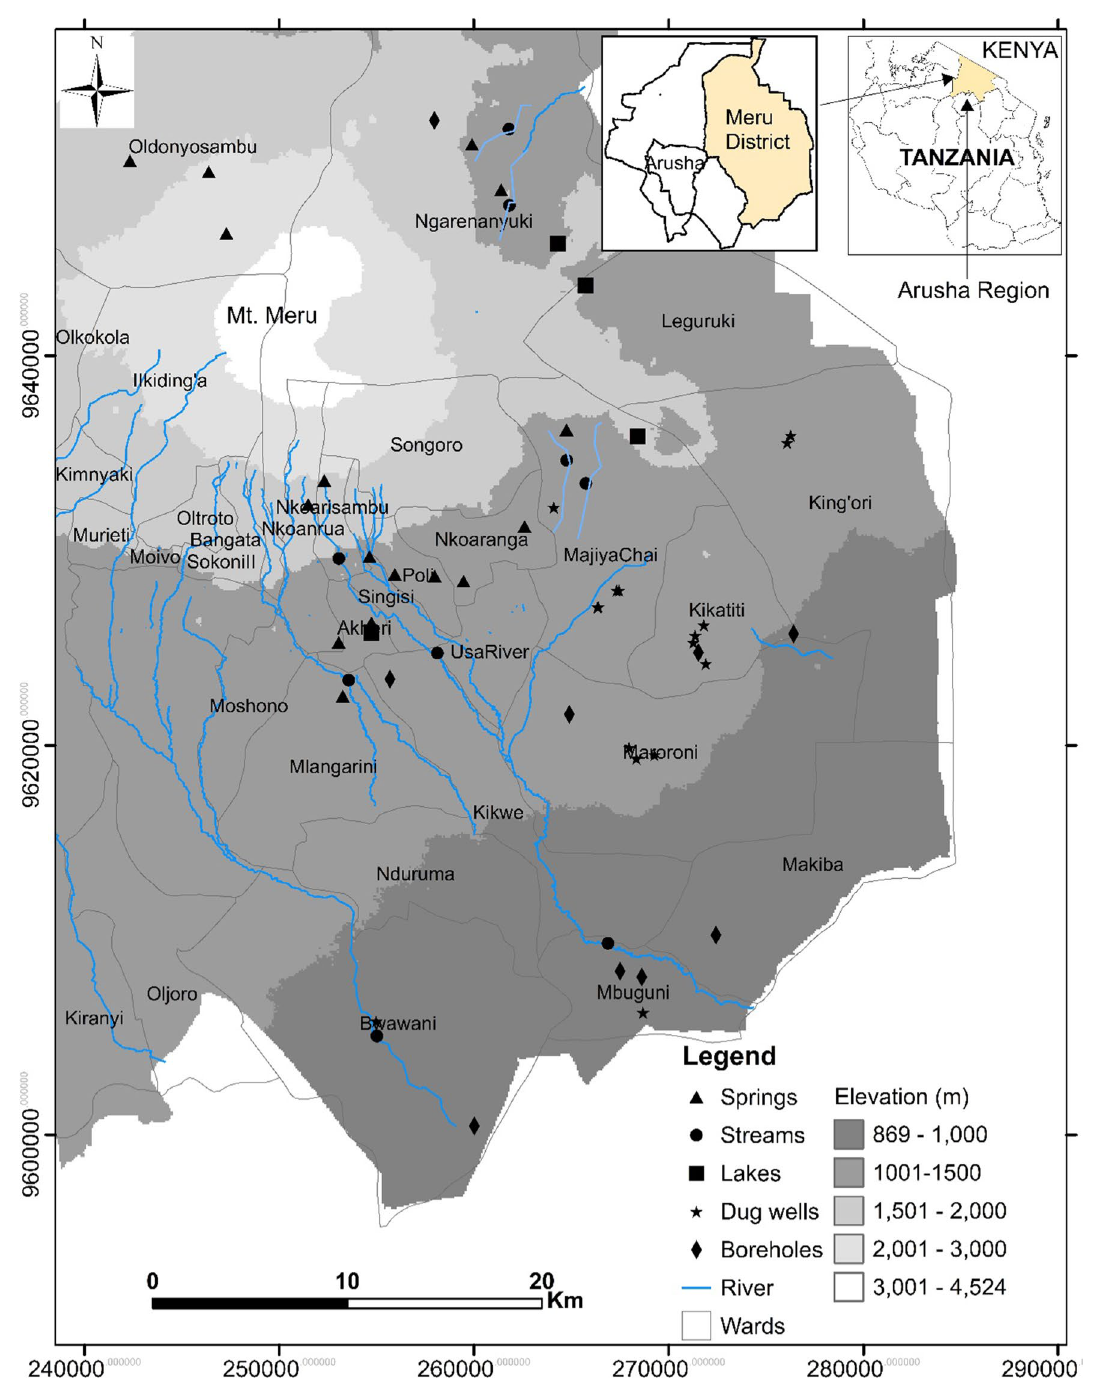
Fig. 1 A map of Meru district showing sampling